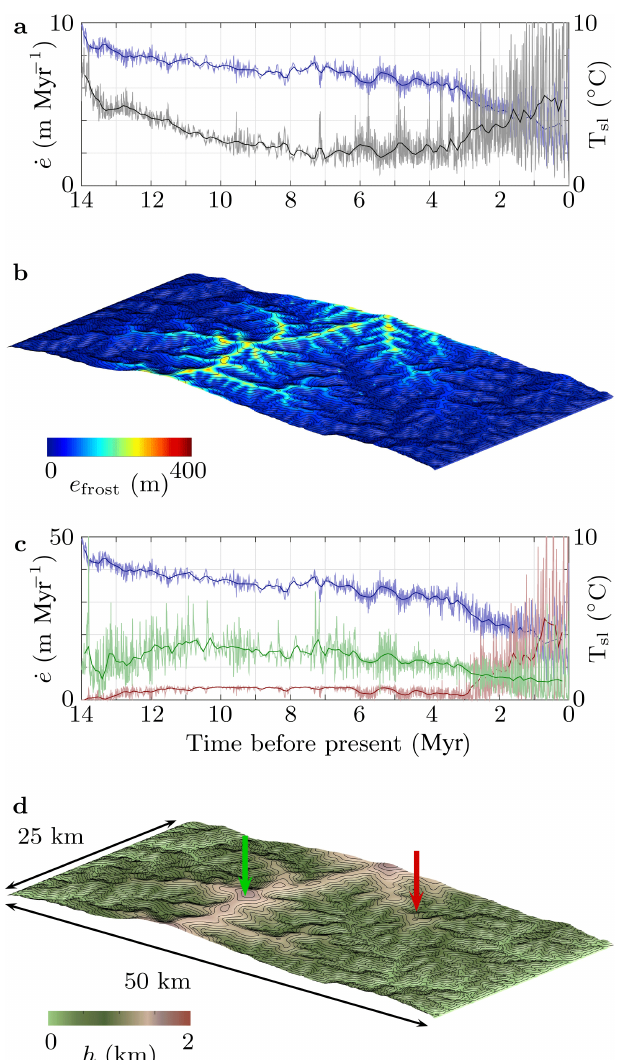
Figure 11. Long-term erosion outcomes for experiment (no. 2) shown in Fig. 10. Panel (a) : sea-level temperature ( T sl , blue) and average erosion rate ( ˙ e , grey) spanning the 14Myr simulation pe- riod. Erosion rates are shown to vary intensely with temperature; the overall trend is highlighted by a running mean (solid black line). Average erosion rate decays through the first 14Myr in response to the gradual smoothing of the summit flats. The effects of cooling takes over in the final 6Myr when average erosion rates accelerate markedly as frost action spreads to lower elevations. Panel (b) : total erosion after 14Myr. Panel (c) : erosion rates measured in the two points marked by arrows in (d) . Both points are at local summits but differ in elevation and therefore experience different temperatures. The high summit (green curve) has relatively high erosion rates at first, but erosion slowly stalls in the final 6Myr because the climate becomes too cold for efficient sediment transport by frost creep. In contrast, the lower summit (red) experiences a significant accelera- tion of erosion in the